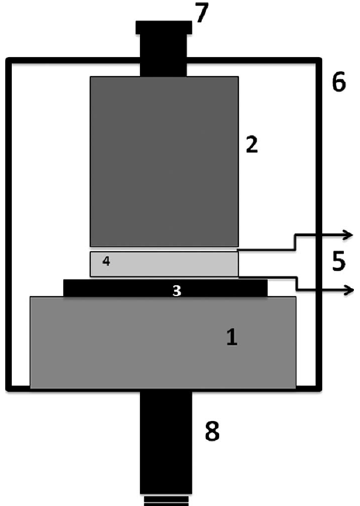
Figure 1. Schematic diagram of the monolithic compression-mode accelerometer assembly [57] (copyright 2010 by the American Institute of